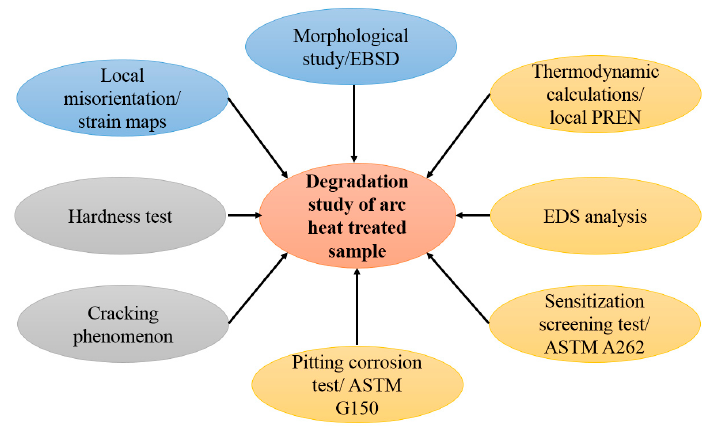
Figure 2. Flowchart of tests and calculations to study the degradation of an arc heat-treated sample. Blue ellipses: Microstructure degradation; gray ellipses: degradation of mechanical properties; orange ellipses: degradation of corrosion resistance.